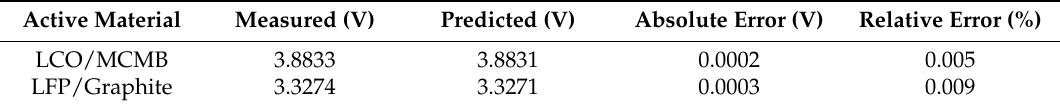
Table 2. Details of the validation results for LCO/MCMB (Cell-1) and LFP/Graphite